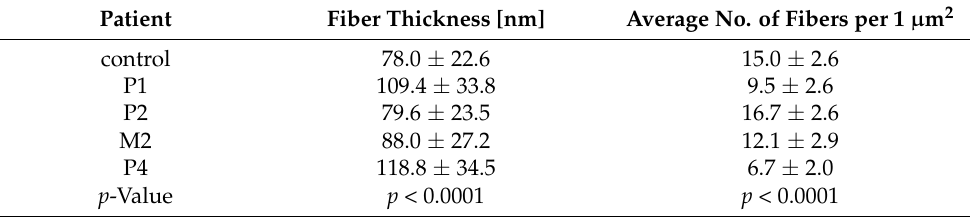
Table 3. Results of fiber thicknesses and average no. of fibers per 1 µ m 2 analysis.